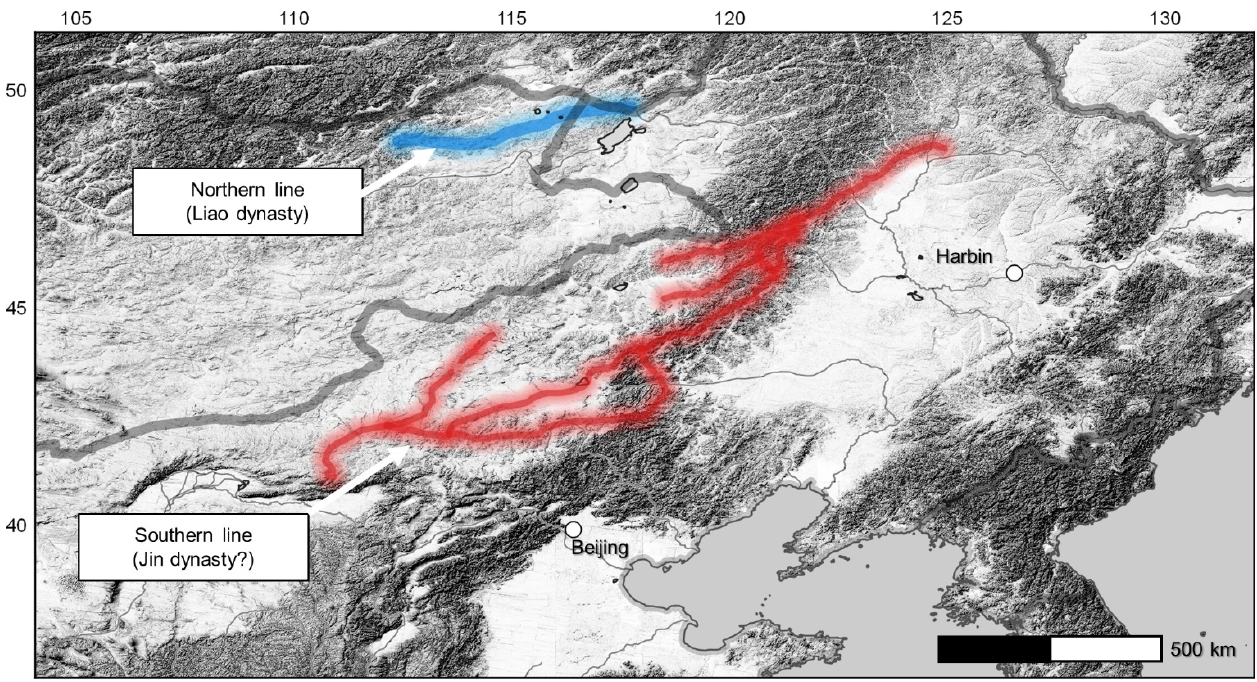
Figure 1. The location of the northern and southern lines of the Medieval Wall System. The southern line is the focus of this study. The locations of this wall are derived from Xie [26].